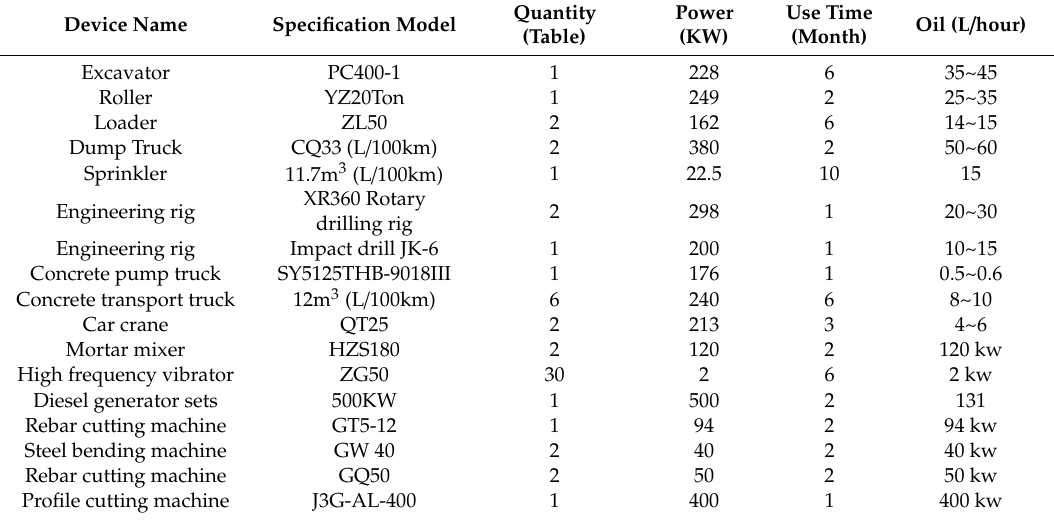
Table 3. Summary table of the operation data of medium and small machines and equipment during construction and